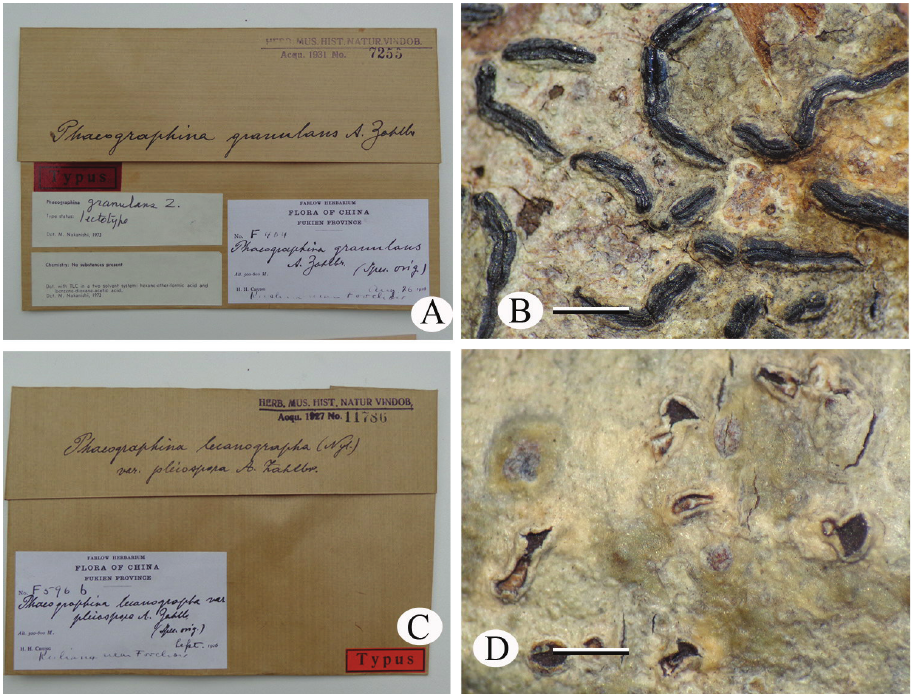
Figure 3. A–B Phaeographina granulans Zahlbr. ( Chung 404 ) C–D Phaeographina lecanographa var. pleiospora Zahlbr. ( Chung 596b ). Scale bars = 1mm.